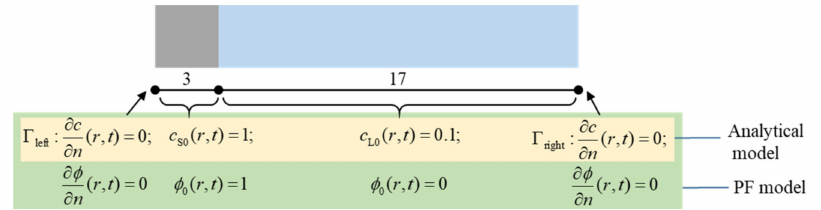
Figure 2. Initial benchmark configurations and boundary conditions for 1D single-component dissolution of a planar solid.